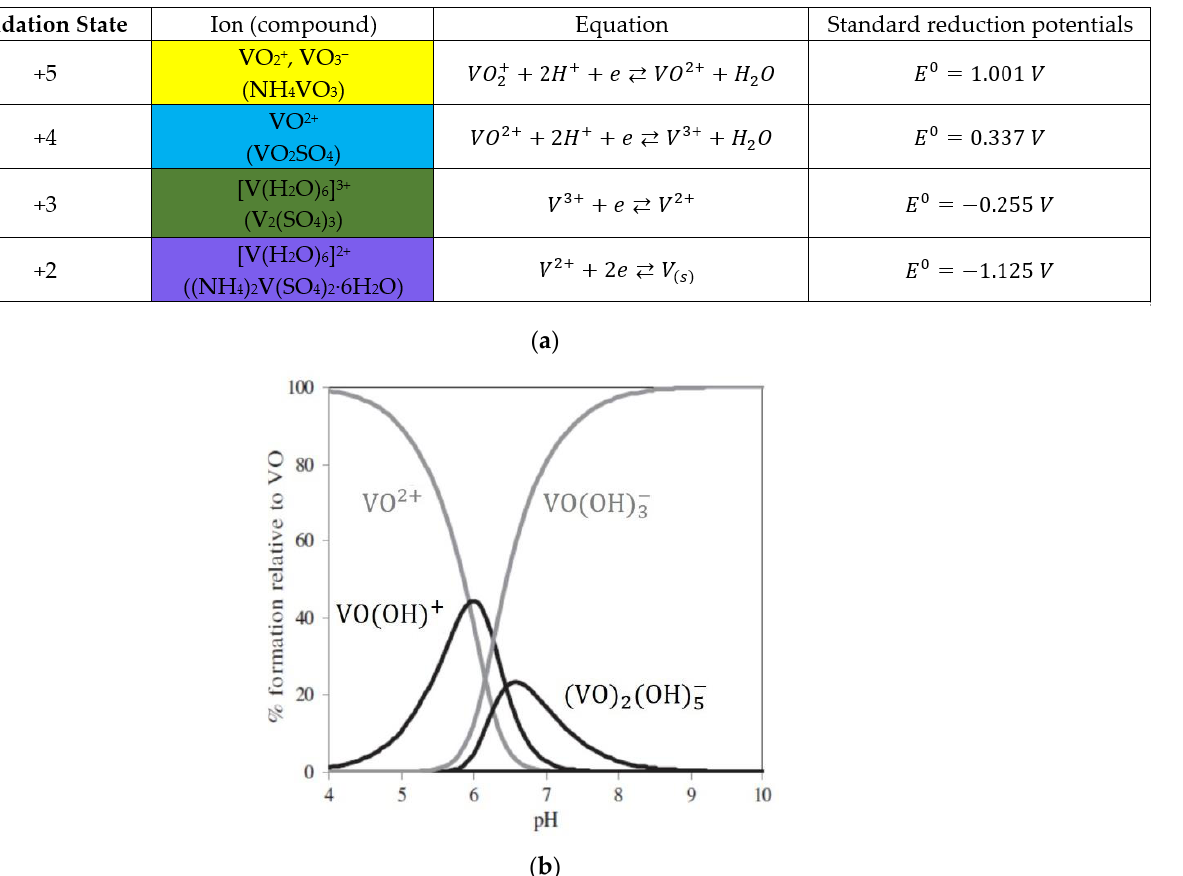
Figure 1. ( a ) oxidation states of vanadium in an aqueous solution, their color and examples of chemi- cal compounds; ( b ) distribution diagram of V(IV) hydrolysis at 10 nM. Reprinted with permission from ref.